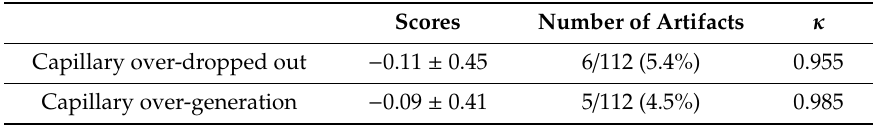
Table 3. Average scores for subjective assessment of artifacts in denoised images and numbers of